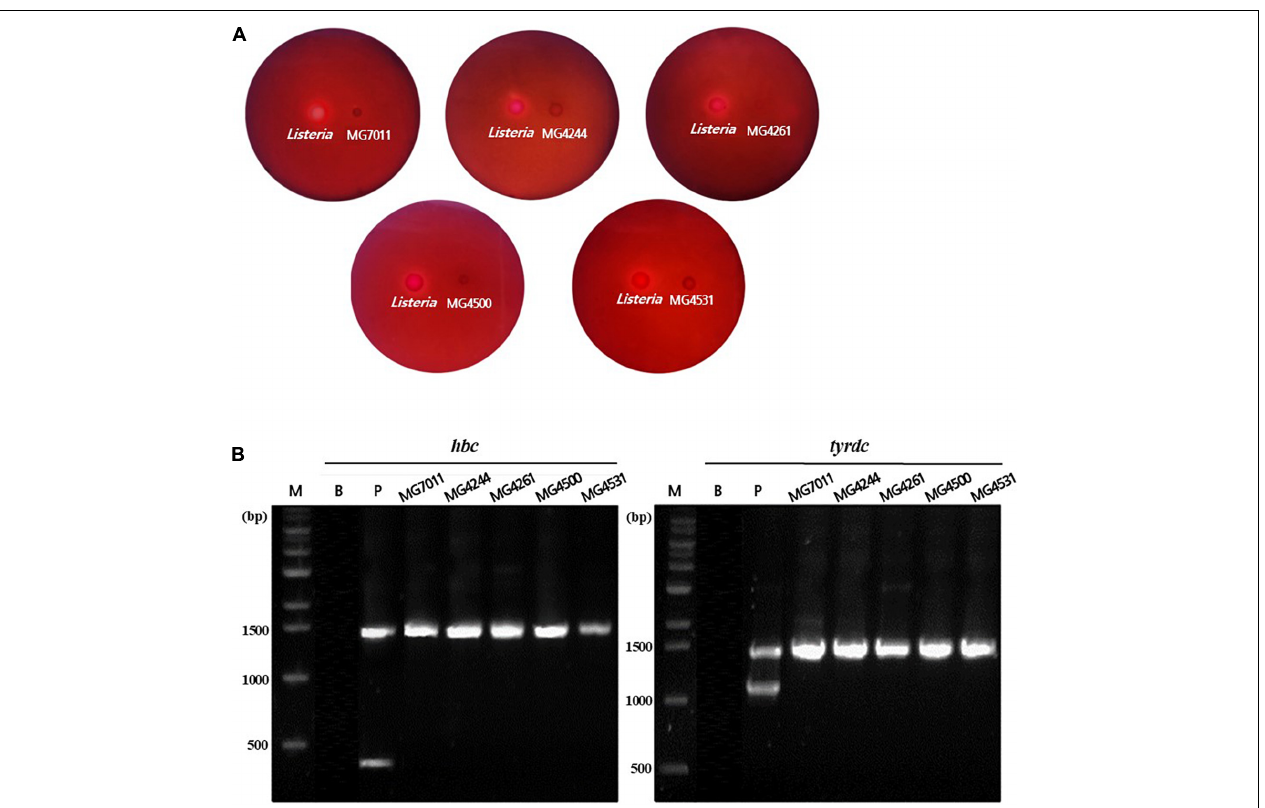
FIGURE 2 | Safety assessment of selected Limosilactobacillus fermentum strains. (A) Hemolytic activity analysis of L. fermentum strains. Hemolytic activity was measured in BHI broth containing 7% horse blood. Left, positive control, Listeria monocytogenes, showing clear zone around the cell drop; right, the MG7011, MG4244, MG4261, MG4500, and MG4531, respectively. (B) Detection of genes related to biogenic amine production. lane M, 1 kb DNA marker; lane B, negative control, which has no template DNA; lane P, positive controls having hdc (histidine decarboxylase, 440 bp), and tyrdc (tyrosine decarboxylase, 1100 bp) genes from Limosilactobacillus reuteri ATCC 23272 and Enterococcus faecalis KCCM 11729, respectively. The DNA of the 16S rRNA gene (1530 bp) was also